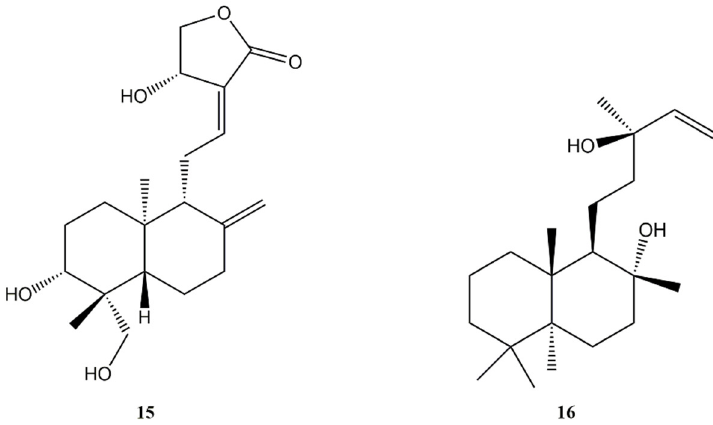
Figure 3. Bioactive labdane diterpenes: Andrographolide ( 15 ); Sclareol ( 16 ). Andrographolide ( 15 ) is the dominant constituent of Andrographis paniculata (Acan- thaceae). It was isolated also from Swertia pseudochinensis (Gentianaceae). Some labdane diterpenes with andrographolide-like skeleton have also been isolated from plants of Asteraceae, Cupressaceae, Lamiaceae, and Zingiberaceae families [99–102]. Several stud- ies reported the potential use of compound 15 in the treatment of colorectal cancer, which is the third-most common cancer worldwide. 5-Fluorouracil (5-Fu) is the most important drug used to treat this cancer. Taking into account that the resistance to the treatment with 5-Fu is a growing concern in colorectal cancer practice, Su et al. [103] explored the effects against colorectal cancer HCT-116 cells of combined 5-Fu and andrographolide ( 15 ). In vitro andrographolide ( 15 ) acted synergistically, enhancing the anti-proliferative effects of 5-Fu due to increased apoptosis. Andrographolide ( 15 ) enhanced the anti-cancer activity of 5-Fu by down-regulating the levels of phosphorylated cellular-mesenchymal to epithelial transition factor. These results confirmed the synergistic action of compound 15 on colorectal cancer cells. Successively, Khan et al. [104] demonstrated that andrographolide ( 15 ) was able to decrease cell viability of colon cancer HT-29 cells in a concentration- and time-dependent manner and to induce apoptosis. These effects appeared to be linked with interference with mitochondrial membrane potential and increased levels of intracellular ROS. More- over, it was found that the diterpene produced cell cycle arrest in G2/M phase at lower concentrations and in the G0/G1 phase at higher concentrations. The potential synergism between andrographolide ( 15 ) and another anti-cancer drug, namely topotecan, an analogue of the natural alkaloid camptothecin, was analysed in acute myeloid U937 cells [105]. Topotecan acts as a topoisomerase I inhibitor and it is used in the treatment of several cancer types including leukemia. Both andrographolide ( 15 ) and topotecan exhibited anti-proliferative properties in a concentration-dependent manner when applied separately. The cells pre-treatment with andrographolide before applying topotecan produced a synergistic activity. Moreover, the cell-cycle arrest at S